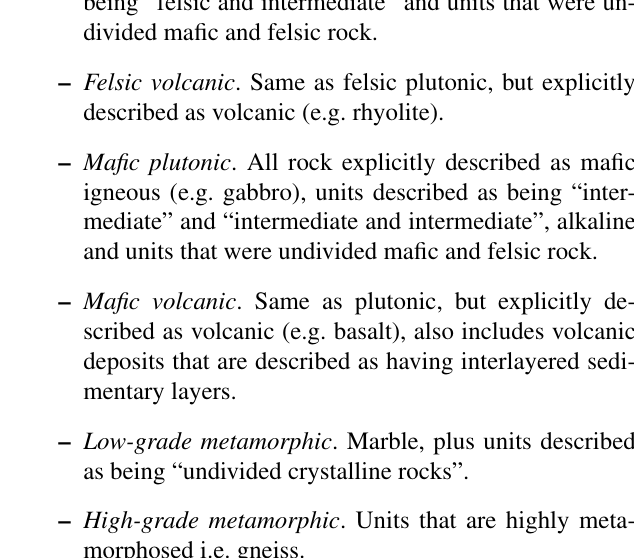
Figure 6. Generalized geology. The red line is the glacial limit during the Last Glacial Maximum, 21000yrBP (Dyke, 2004). The rock types are divided into sedimentary, felsic and mafic, volcanic and plutonic, and metamorphic